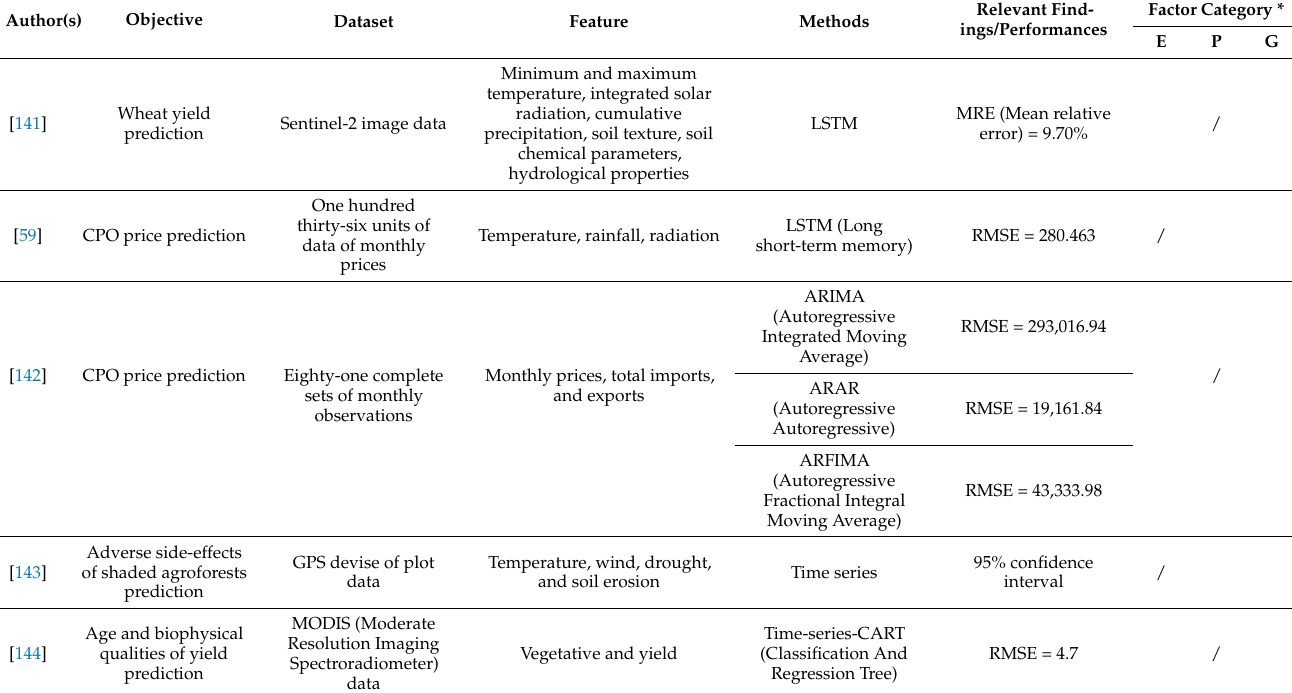
Table 8. Time-series prediction of crops and palm